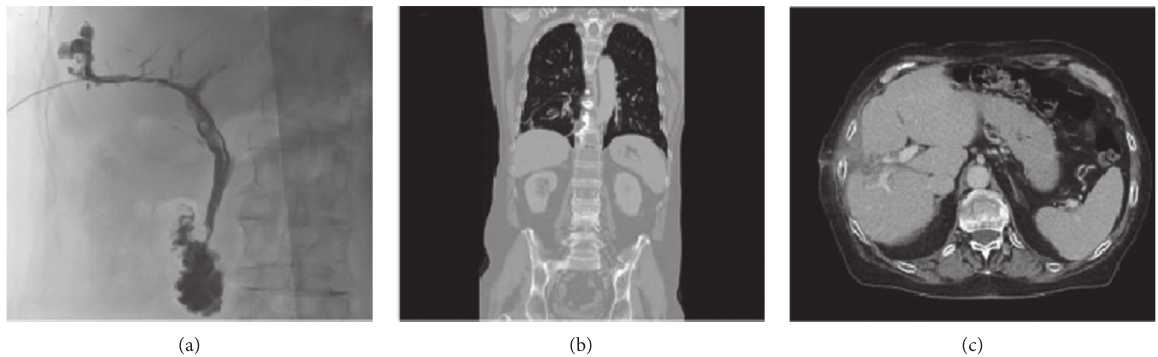
Figure 5: Percutaneous cholangiography (a) and chest-abdomen CT scan (b, c) showing resolution of previous bile leakage. Table 1: Six cases of thoracobiliary fistula following thermal ablation of liver metastases. Author Primary